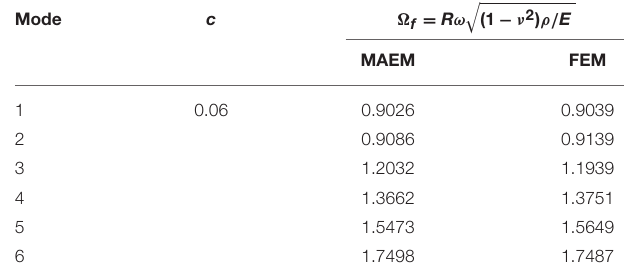
TABLE 2 | Eigenfrequency parameters of the shell in Example 2.